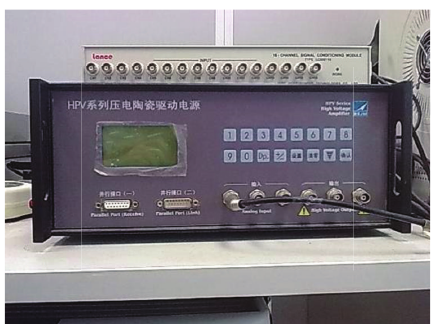
Figure 5: Piezoelectric driving power.